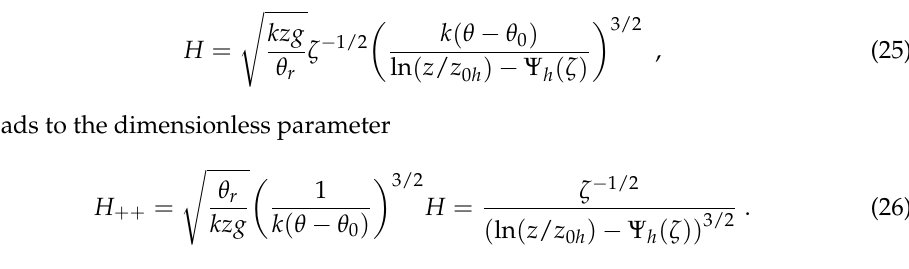
m listed in Section 3 (z 0 = 0.5